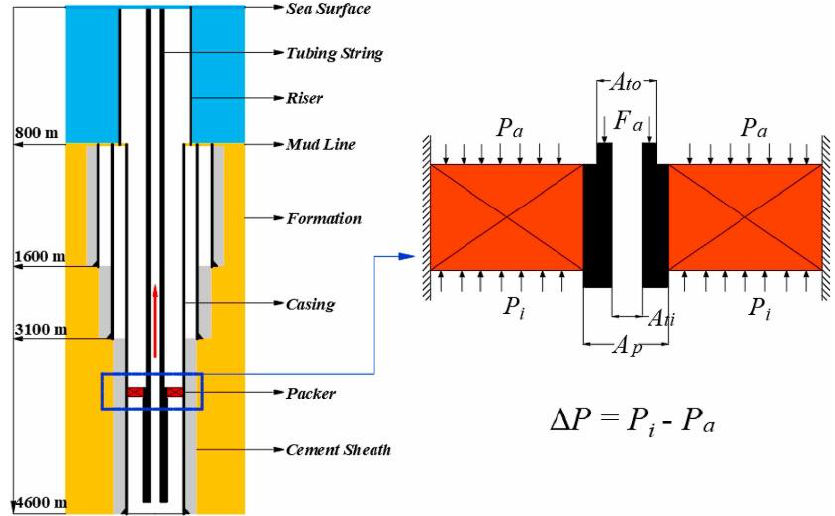
Figure 11. Forces applied to the packers during the completion test in the HPHT gas well [68].